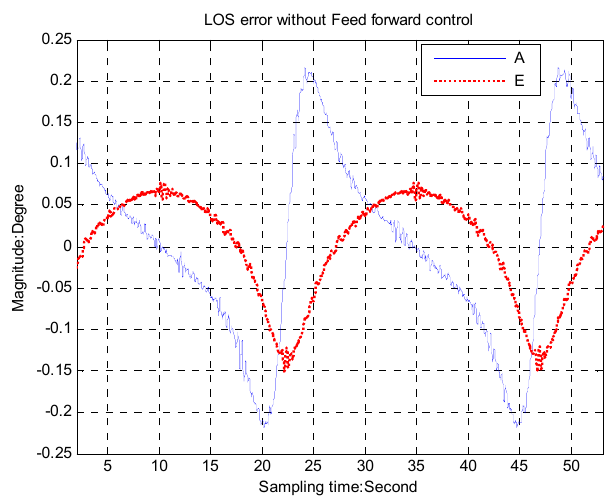
Figure 12. The LOS error without feed forward control.